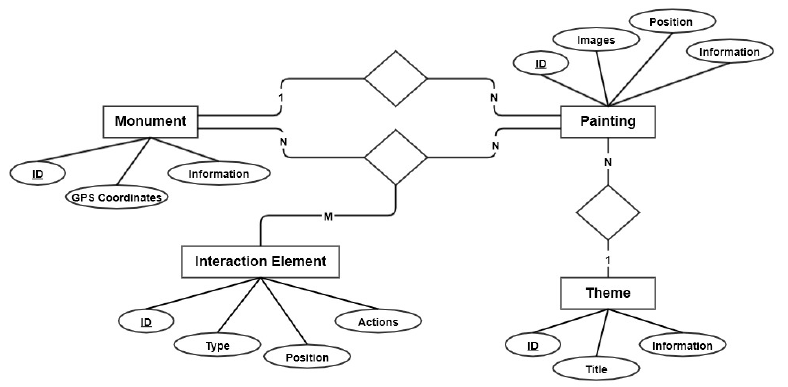
Figure 10. Database’s Entity-Relationship diagram.